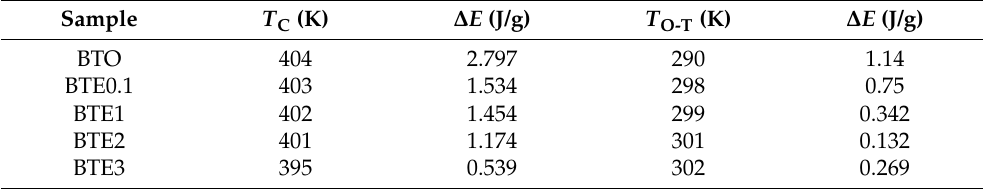
Figure 7. Temperature dependences of the specific heat for different compositions of BTEx ceramics: ( a ) BET0.1, ( b ) BTE1, ( c ) BTE2, and ( d ) BTE3. The dashed line illustrates the background coming from the lattice part of the specific heat. Table 1. Temperatures of dielectric anomalies corresponding to successive phase transitions in BTEx ceramics together with the values of latent heat Δ E corresponding to a particular phase transition.